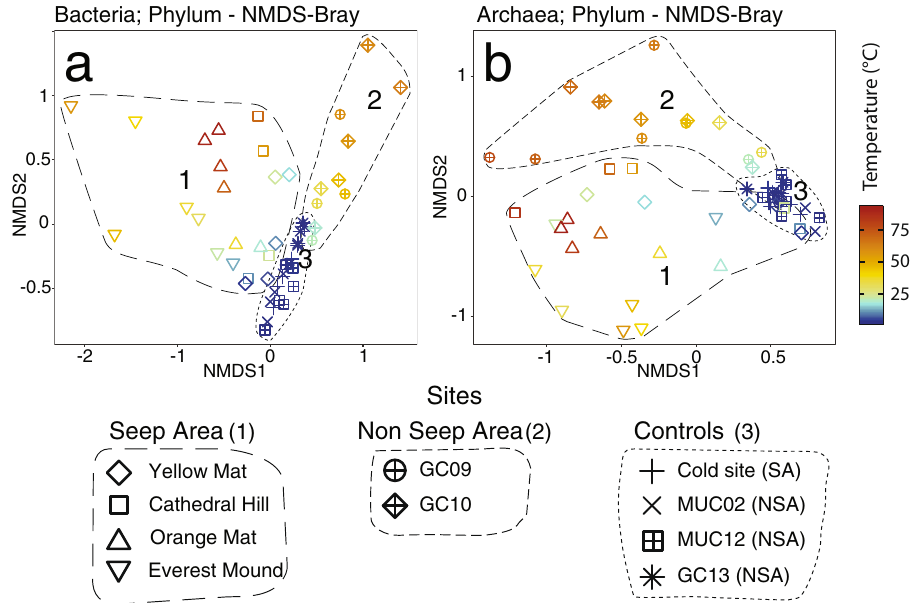
Fig. 5 Microbial community fi ngerprints in relation to temperature and locations. Non-metric multidimensional scaling (NMDS) plots, calculated with Bray – Curtis algorithms, of phylum-level ( a ) bacterial and ( b ) archaeal community structure. Symbol colors indicate sample in situ temperatures. Cold control sites from both locations are grouped together in the legend for easier viewing. For NMDS plots at the class- and Zero-noise operational taxonomic unit (ZOTU)-level, see Supplementary Fig.